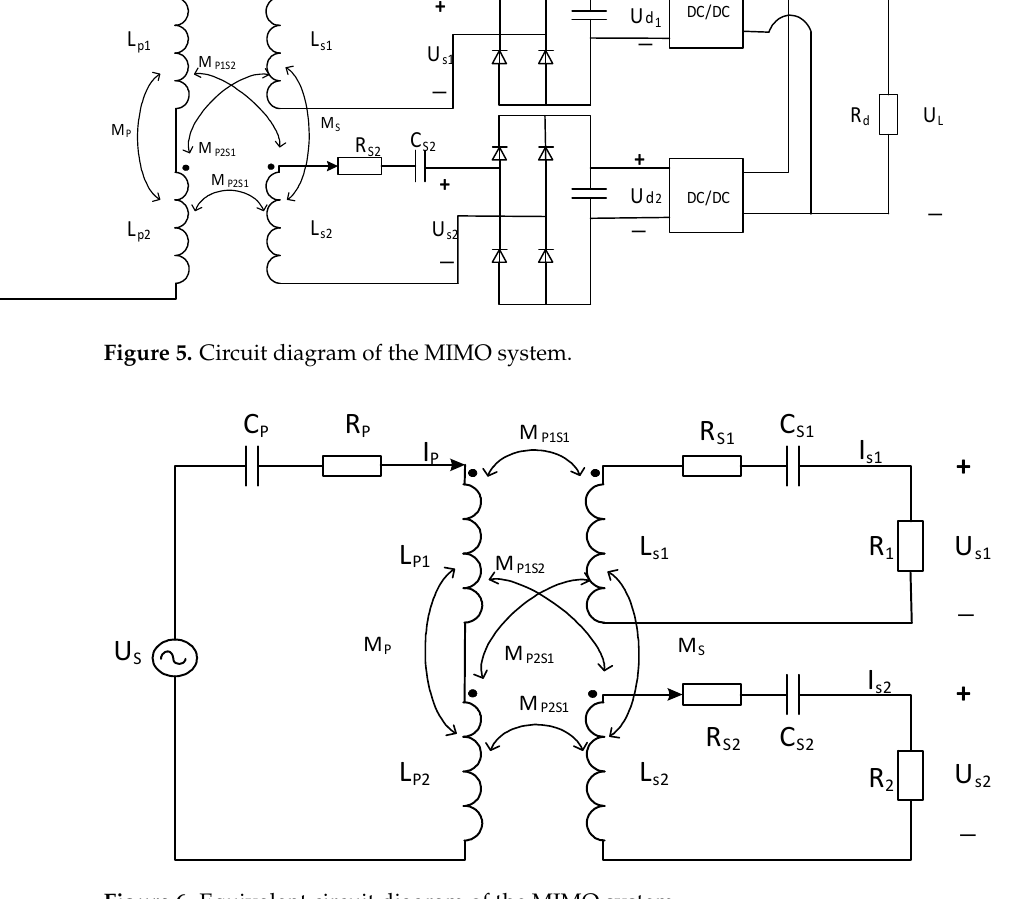
Figure 6. Equivalent circuit diagram of the MIMO system. In Figure 6, t hree voltage equations for the primary and secondary loops are ex- pressed in Equation (2).